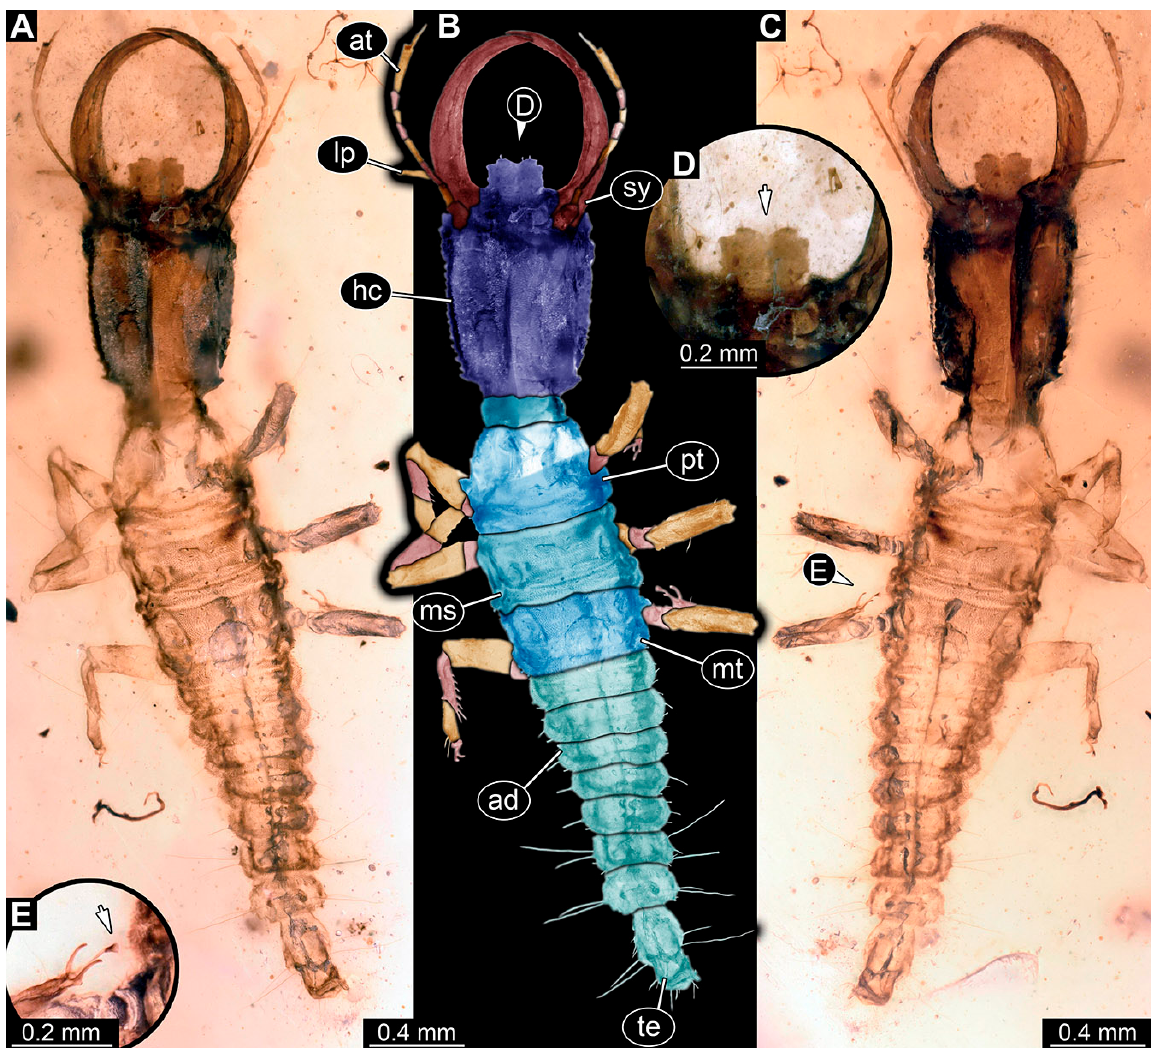
Figure 20. Specimen 81 (PED 1813); Myanmar amber. ( A ) Dorsal view. ( B ) Dorsal view, colour- marked. ( C ) Ventral view. ( D ) Close-up of labrum in dorsal view; arrow marks middle cleft of the labrum. ( E ) Close-up of third locomotory appendage; arrow marks empodium. Abbreviations: ad = abdomen; at = antenna; hc = head capsule; lp = labial palp; ms = mesothorax; mt = metathorax; pt = prothorax; sy = stylet; te = trunk end.